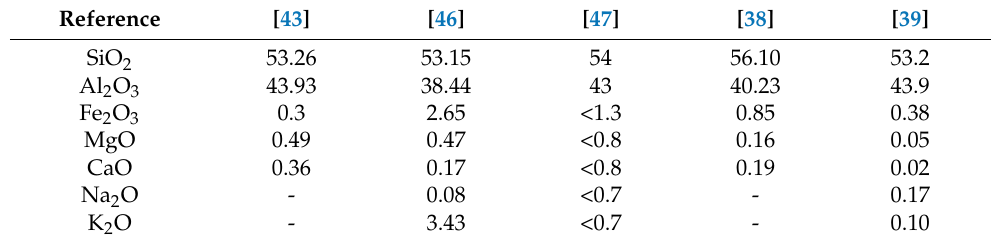
Table 2. Chemical composition of Metakaolin (MTK).